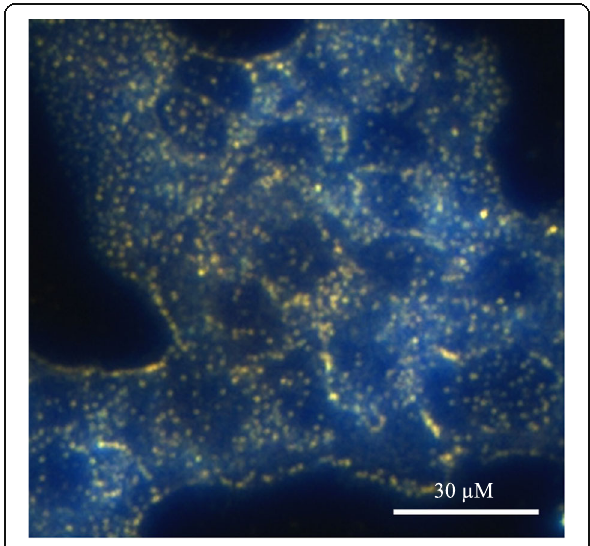
Fig. 6 Darkfield imaging of A431 lung cancer cells treated with AuNPs; the bright yellow/orange dots are nanoparticles within the